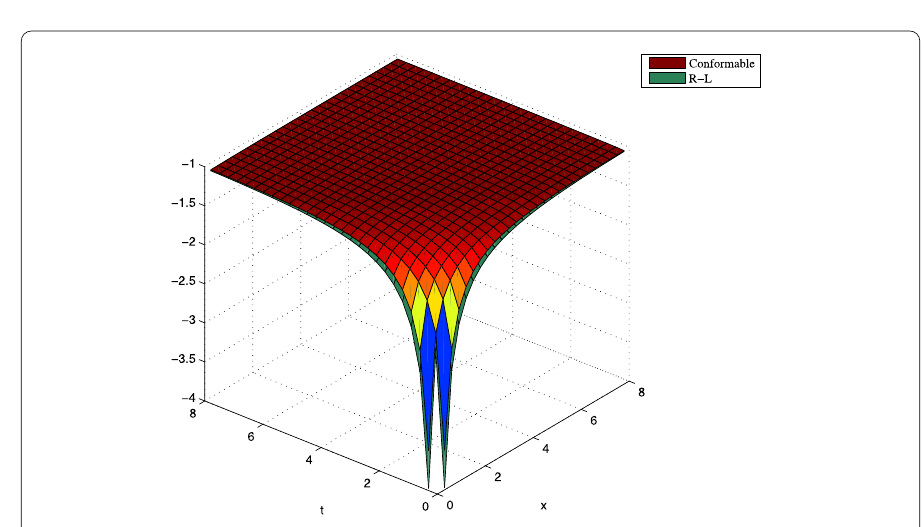
4.2 Exact solutions of the space-time fractional Drinfeld’s Sokolov–Wilson